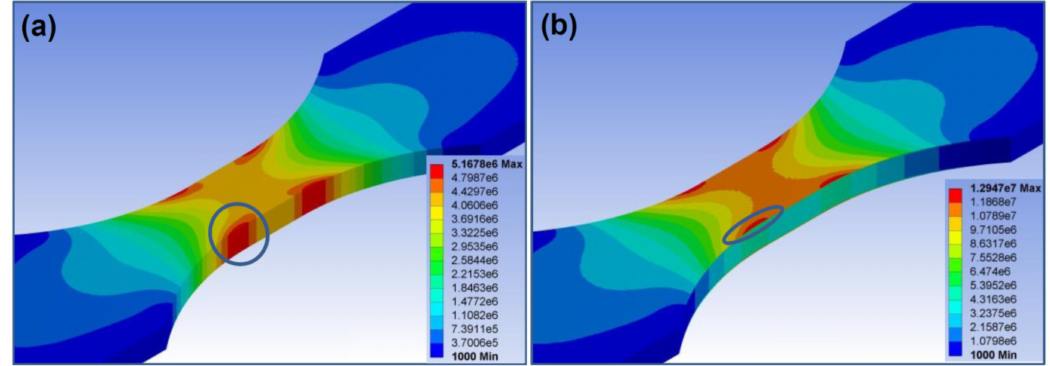
Figure 8. Cloud images of damage for the coated ( a ) and uncoated ( b ) fatigue specimens under 390 MPa obtained by the finite element method with a sinusoidal cyclic loading